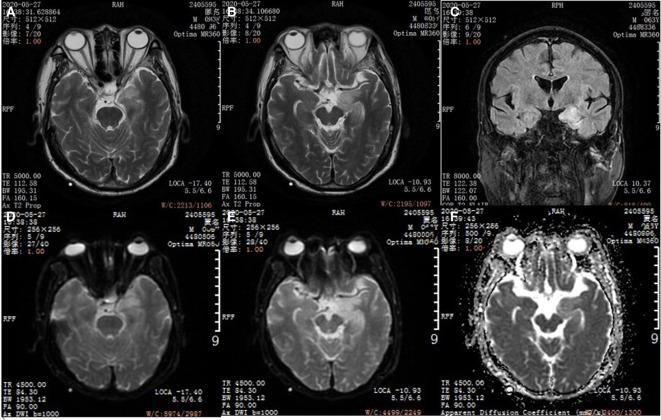
Head magnetic resonance imaging (MRI). (A,B) T2WI axial image in a patient with anti-GABA B encephalitis. (C) FLAIR corona scanning. (D,E) DWI axial image. (F) ADC axial image.